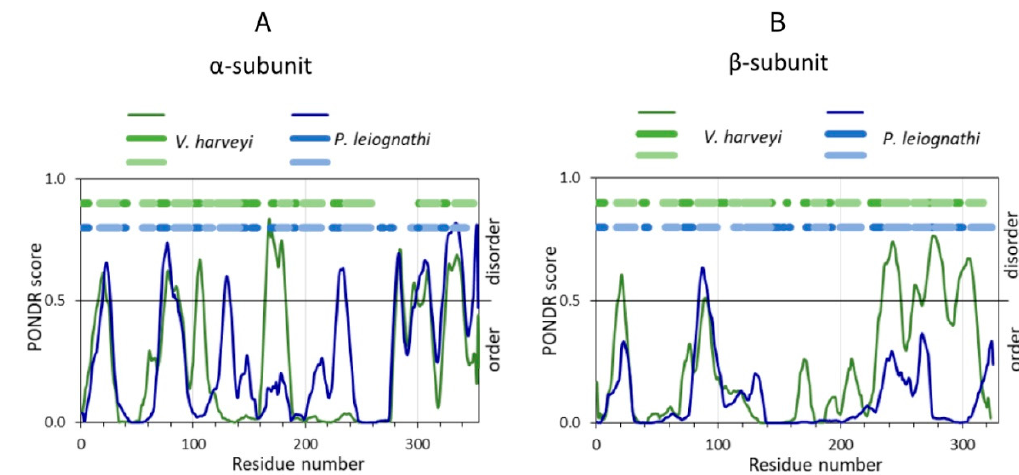
Figure 5. Intrinsic disorder propensities for amino acid sequences of the α -subunit ( A ) and β -subunit ( B ) of the luciferases V. harveyi (green lines) and P. leiognathi (blue lines), as predicted with PONDR FIT [33]. Horizontal thick lines refer to the position of the amino acids, which are included in an α -helix (lighter color) or β -strand (darker color). Distribution of secondary structure segments in polypeptide chains was retrieved using UCSF Chimera